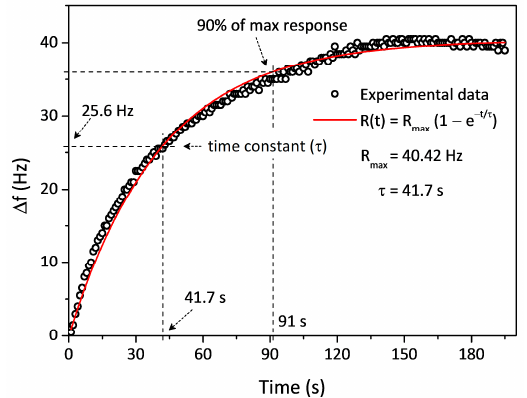
Figure 6. The frequency shift of chitosan-based QCM sensor after being exposed to 7 mg·L − 1 n-amyl alcohol.